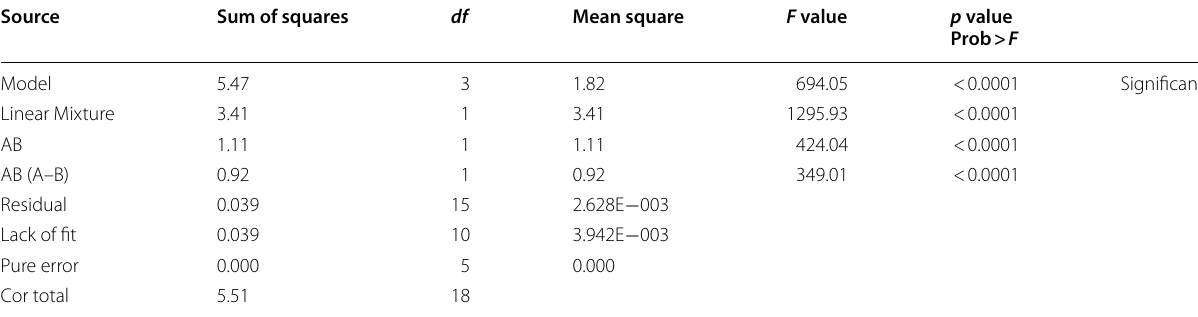
Table 3 Software generated ANOVA table considering retention time of chlorimuron-ethyl as Response 3